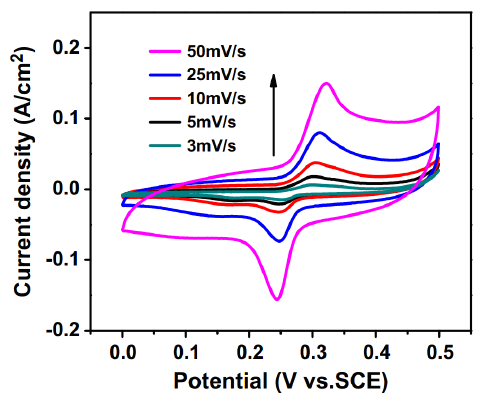
Figure 6. CVs of 1.50 mol% La 3+ -doped NiO electrode measured at scan rates from 3 to 50 mV·s − 1